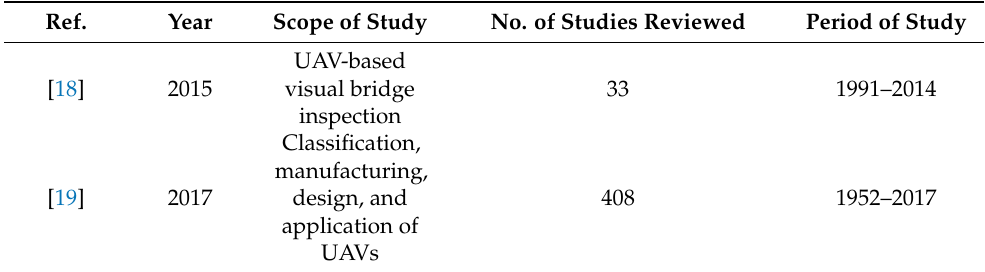
Table 1. Previous review work related to the application of UAVs in bridge condition monitoring.